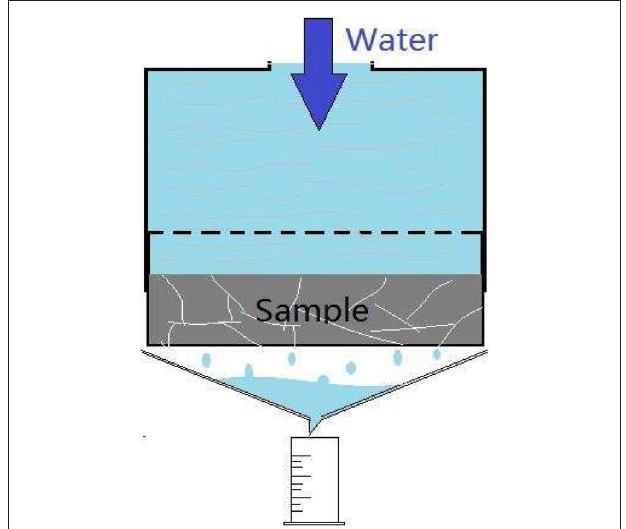
FIGURE 3 | Schematic diagram of water permeability test.